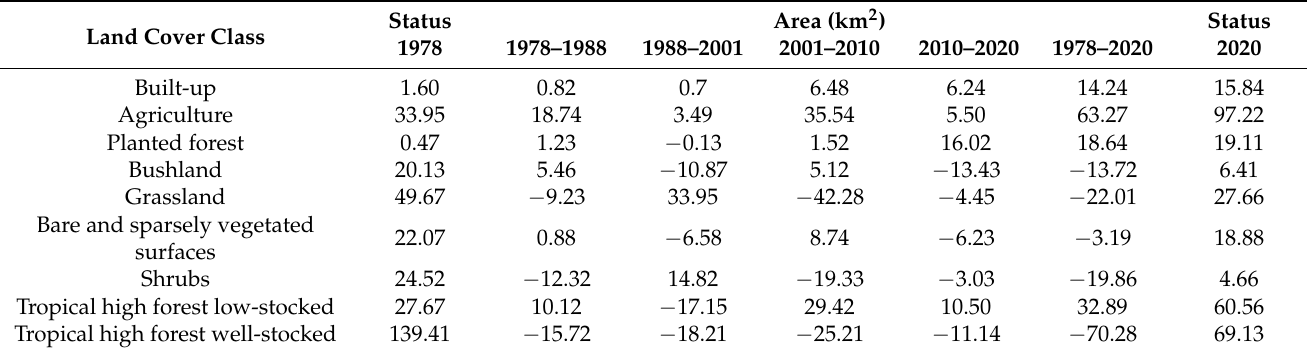
Figure 6. The classified land cover maps for 1978 ( a ), 1988 ( b ), 2001 ( c ), 2010 ( d ), and 2020 ( e ) of upper Manafwa watershed. Table 5. The decadal land cover changes for the period from 1978 to 2020 showing the area changes in km 2